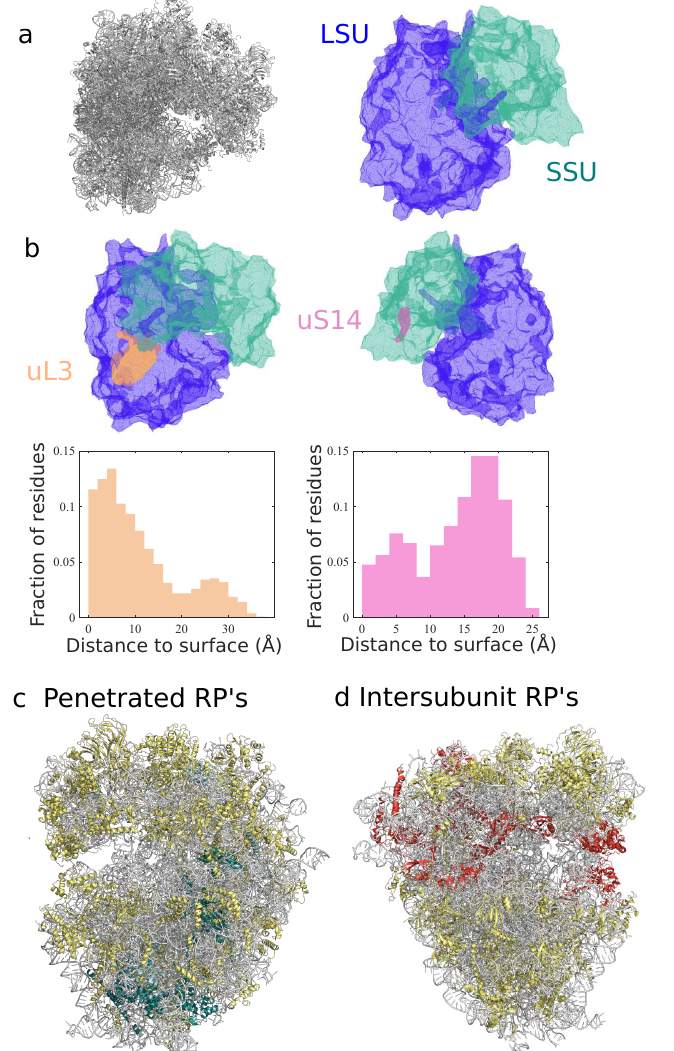
Figure 4. Interpolation of ribosome shape serves for protein spatial classification. Using a geometric descriptor called α -shape [101], we interpolated in ( a ) the surface of the human ribosome from the cryo-EM 3D structure [20]. Distance of any residue to the solvent-exposed surface can then be measured, yielding protein-specific distributions of distance, illustrated in ( b ) for two proteins of the large and small subunits, uL3 and uS14. This quantitative evaluation enables various spatial classifications of the ribosomal proteins, based on their degree of penetration inside the ribosome (( c ), with deeply buried RP’s shown in blue) or localization in specific regions (as in ( d ), with intersubunit proteins shown in